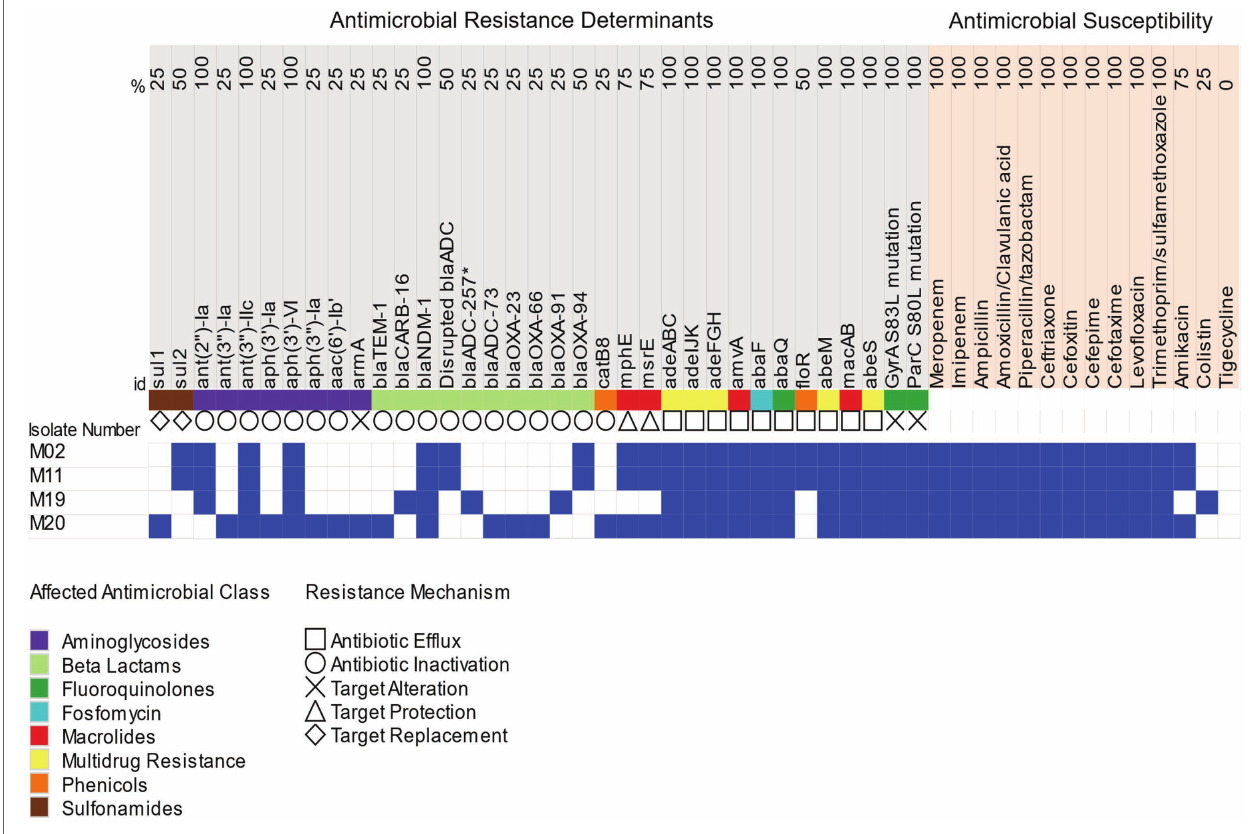
FIGURE 2 | Antimicrobial resistance profiles and distribution of antimicrobial resistance determinants in the bla NDM -positive isolates. Blue colors denote antimicrobial resistance and harbored antimicrobial determinants, while susceptibility to antimicrobials and lack of resistance determinants are denoted by white colors; bla ADC-257 *, novel bla ADC allele identified in